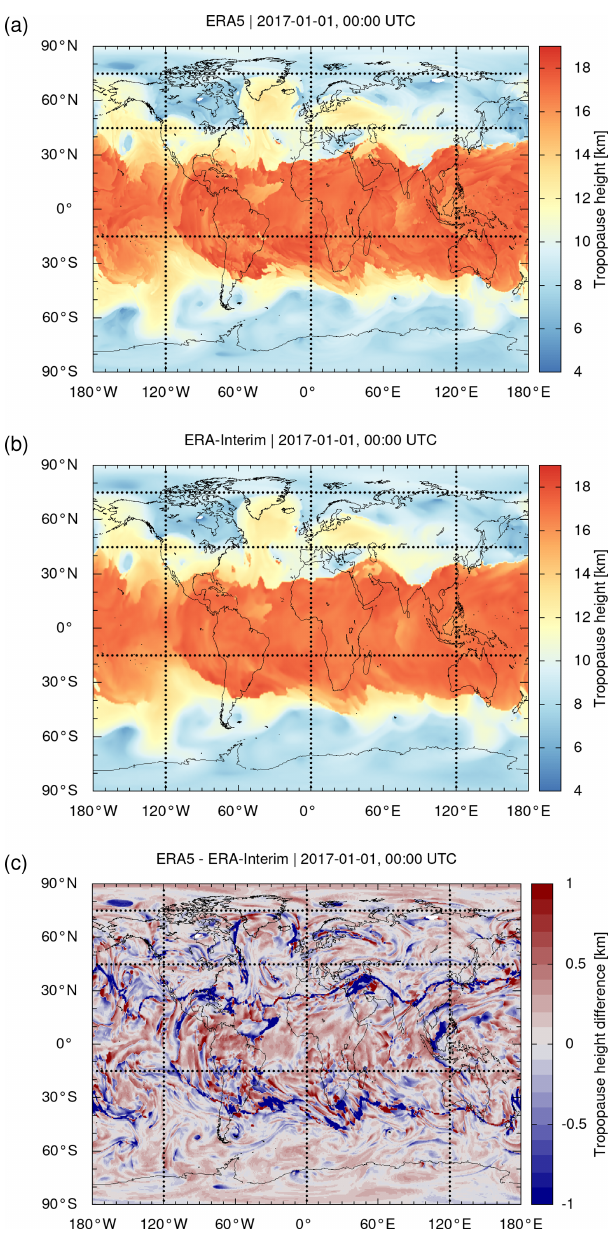
Figure 2. Global maps of (a) ERA5 and (b) ERA-Interim WMO first tropopause geopotential heights on 1 January 2017, 00:00UTC. Differences of ERA5 minus ERA-Interim are shown in panel (c) . The data were sampled on a 0 . 3 ◦ × 0 . 3 ◦ horizontal grid. Meridional and zonal cross sections along the dotted lines are shown in Figs. 3 and 4,